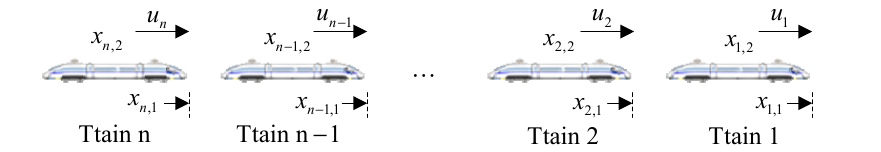
Figure 1. The diagram of multiple urban rail trains motion.